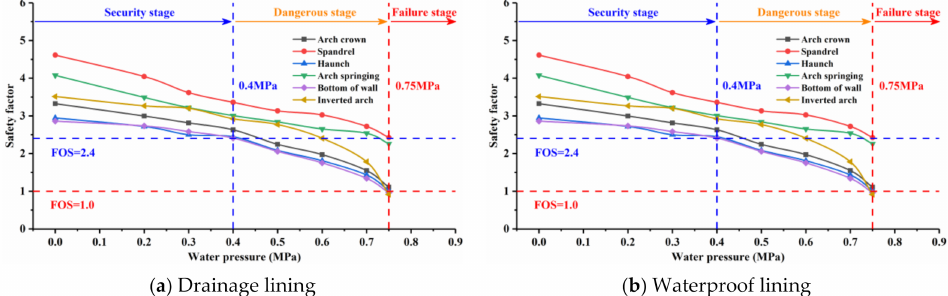
Figure 15. Relationship between the safety factor and the water pressure. The test results indicate the